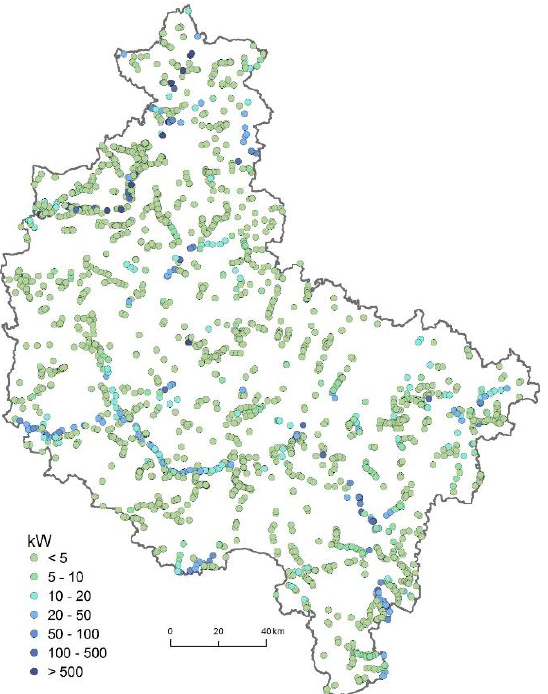
Figure 11. Hydrotechnical structures in the Greater Poland Voivodeship (own calculations).